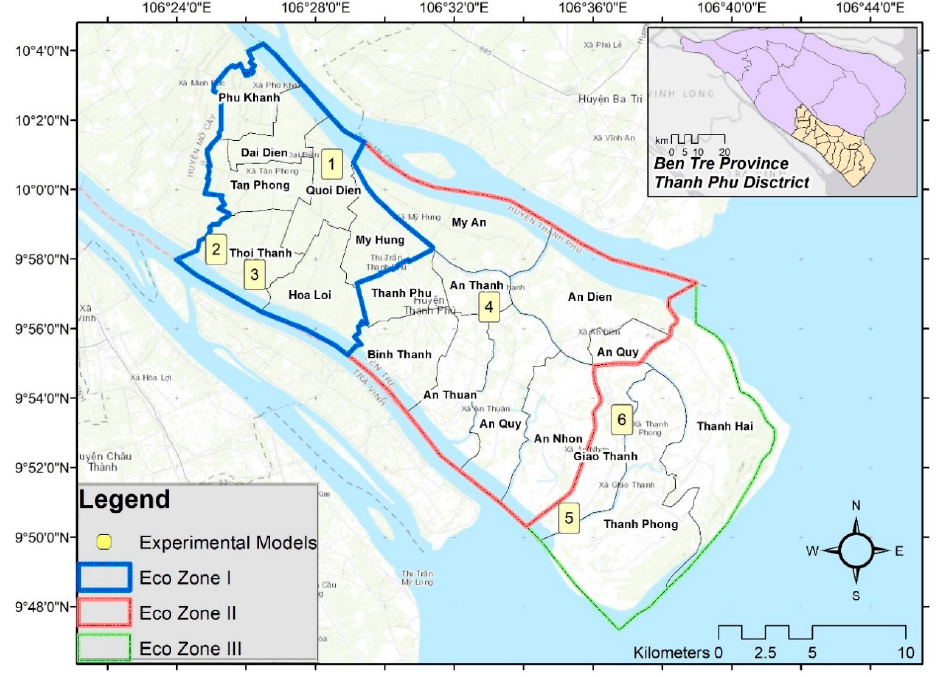
Figure 1. Administrative map of the Thanh Phu district with sampling points.